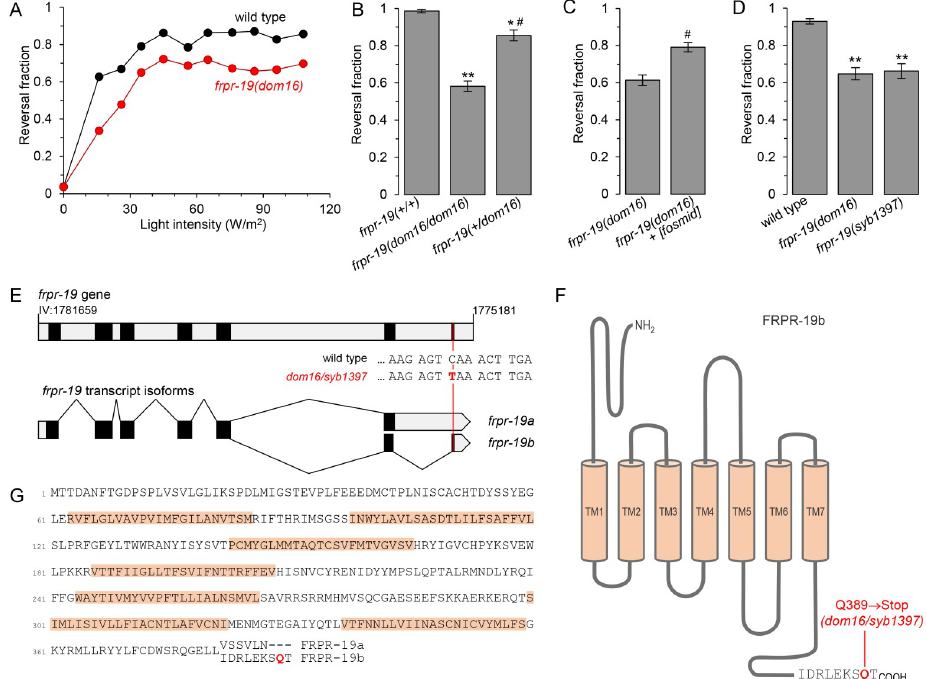
Fig 1. A nonsense mutation in frpr-19 reduces FLP neuron-dependent reversals. (A) Light intensity-response curves of wild type and frpr-19(dom16) mutants. All animals contained the domIs272[FLP :: CoChR] transgene enabling the optogenetic activation of FLP. Reversal fraction scored over 5 trials per animals. n = 100 animals. (B, C, D) Fraction of FLP optogenetic stimuli producing a reversal response as in A, with 61 W/m 2 light stimuli, and showing the slight semi-dominance of the frpr-19(dom16) allele (B), the rescue effect with a WRM0623dC10 ( frpr-19- containing) fosmid (C), and a phenocopy effect by an frpr-19(syb1397) CRISPR/Cas9 engineered allele causing the same mutation as dom16 (D). �� , p < .01; � , p < .05 versus wild type control and #, p < .01 versus frpr-19(dom16) homozygotes by Bonferroni contrasts. (E) Structure of the frpr-19 gene on the (-) strand of chromosome IV (note the genomic coordinates) and of the two transcript isoforms formed by alternative splicing in the 3’ region of the gene. Coding exons (black), introns and UTRs (grey), nucleotide change causing the nonsense mutation (red). (F) Predicted topology of FRPR-19B with the isoform-specific primary sequence highlighted. (G) Primary sequence of FRPR-19A/B, with an alignment of the divergent sequence between the two isoforms at the C-terminus.